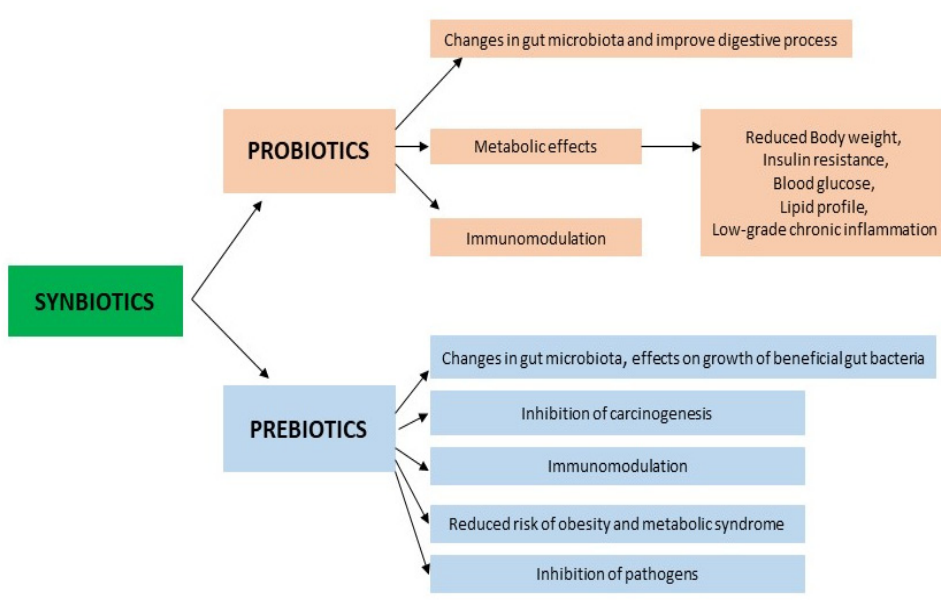
Figure 2. Mechanisms and effects of synbiotics. More details in text.